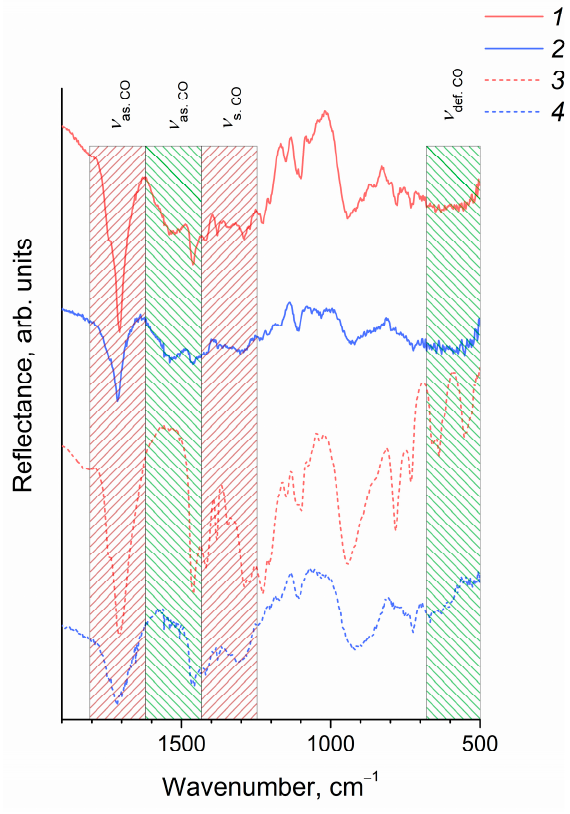
Figure 5. The IR spectra of CeO 2 sols in heptane stabilized with ( 1 ) 2-ethylhexanoic and ( 2 ) octanoic acids. The IR spectra of ( 3 ) 2-ethylhexanoic and ( 4 ) octanoic acids are shown for comparison.